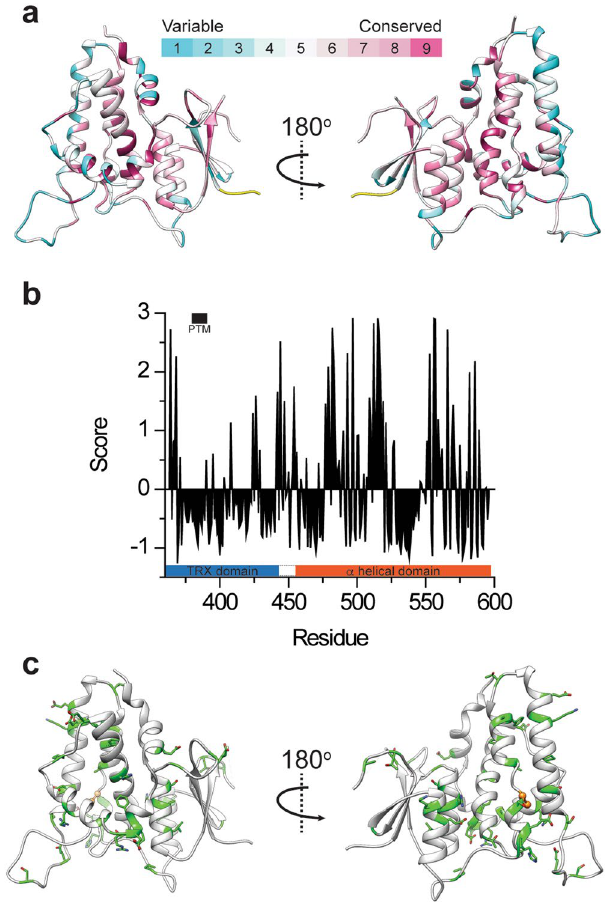
Figure 3. Conservation analysis and disease-associated mutation distribution in mCLIC6. ( a ) mCLIC6 structure colored according to the conservation score of each residue as determined by Consurf. ( b ) Conservation score for each residue. Negative values indicate conservation while positive values indicate variability. The sequence refers to the crystallized mCLIC6. ( c ) Cancer associated mutation positions (green sticks), mapped onto the structure of mCLIC6. A461, involved in both familial goiter and cancer, is shown as orange